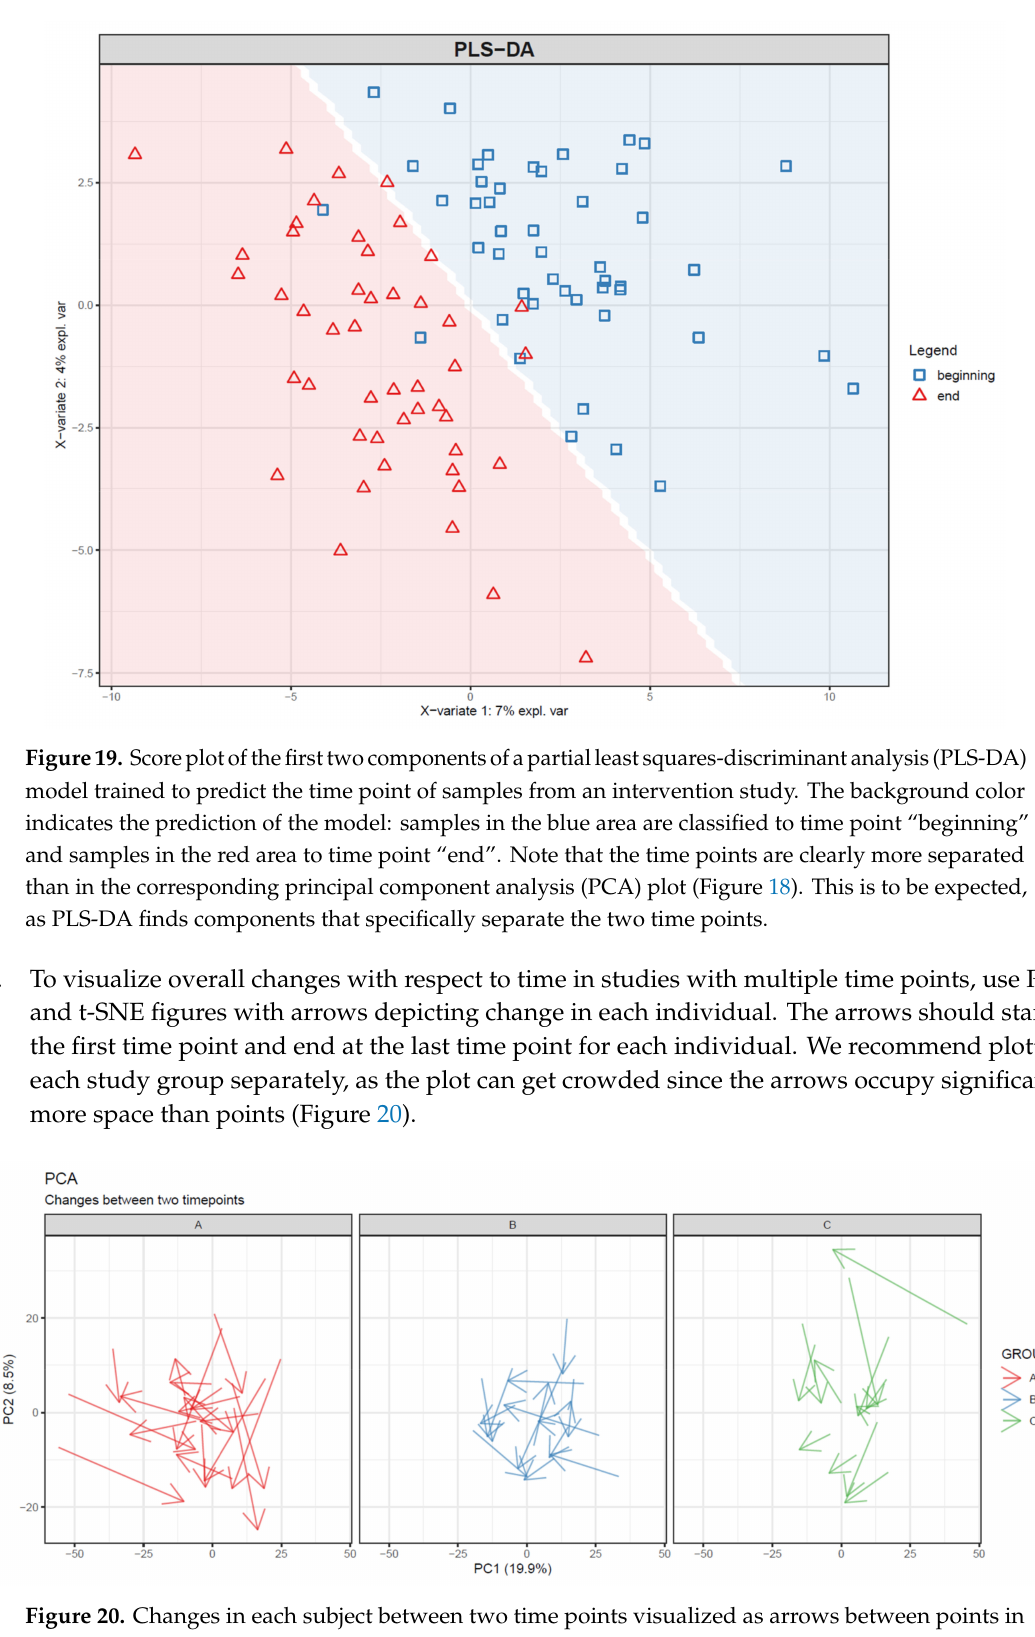
Figure 20. Changes in each subject between two time points visualized as arrows between points in a principal component analysis (PCA) plot. Samples in di ff erent groups are separated into subplots. While no group shows a systematic direction of change, we can observe that the subjects in group A show greater overall change that subjects in the other